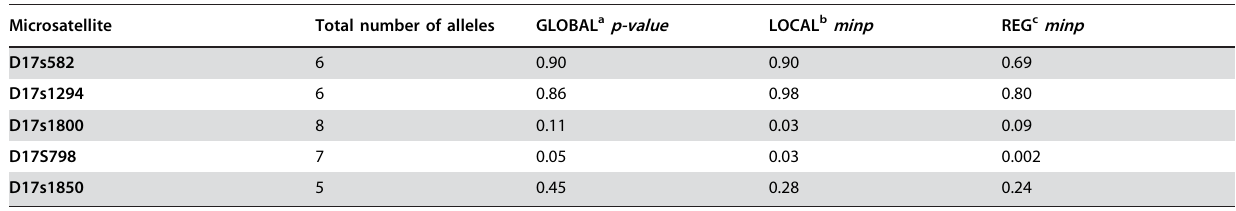
Table 1. Association testing of each of the microsatellites selected for genotyping in the 17q11.2 region of DNA. .. ... .... ... ... .... ... ... .... ... ... .... ... ... .... ... ... .... ... ... .... ... ... .... ... ... .... ... ... .... ... ... .... ... ... .... ... ... .... ... ... .... ... ... . Microsatellite Total number of